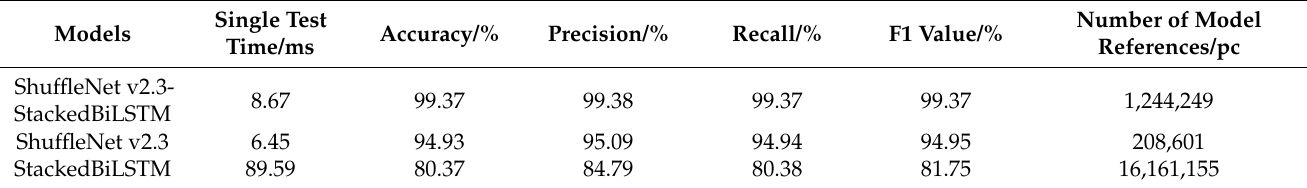
Figure 7. Confusion matrix for different models:( a ) ShuffleNet v2.3-StackedBiLSTM classification model confusion matrix test results; ( b ) ShuffleNet v2.3 classification model confusion matrix test results; ( c ) StackedBiLSTM classification model confusion matrix test results. Table 6. Comparison of experimental results of different